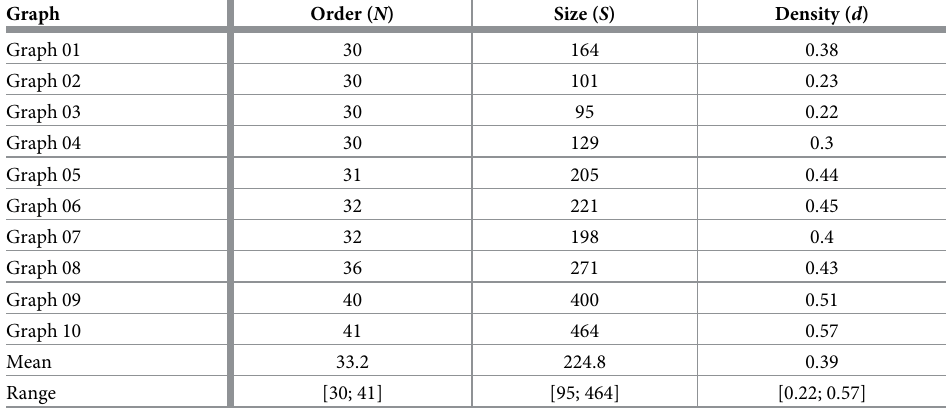
Table 1. Main features of empirical graphs: Order (number of nodes), size (number of edges), and edge density (ratio between the size and the graph maximum size). Graph